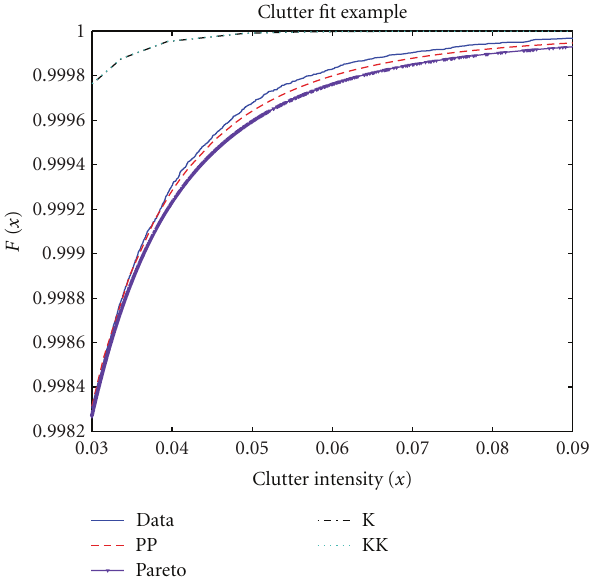
Figure 3: Clutter fit example, showing the empirical distribution functions F ( x ) for real Ingara data compared to the fitted Pareto, Pareto mixture (PP), K- and KK-Distributions, as a function of intensity x . Here the latter two coincide almost exactly, while the Pareto mixture provides the best fit.